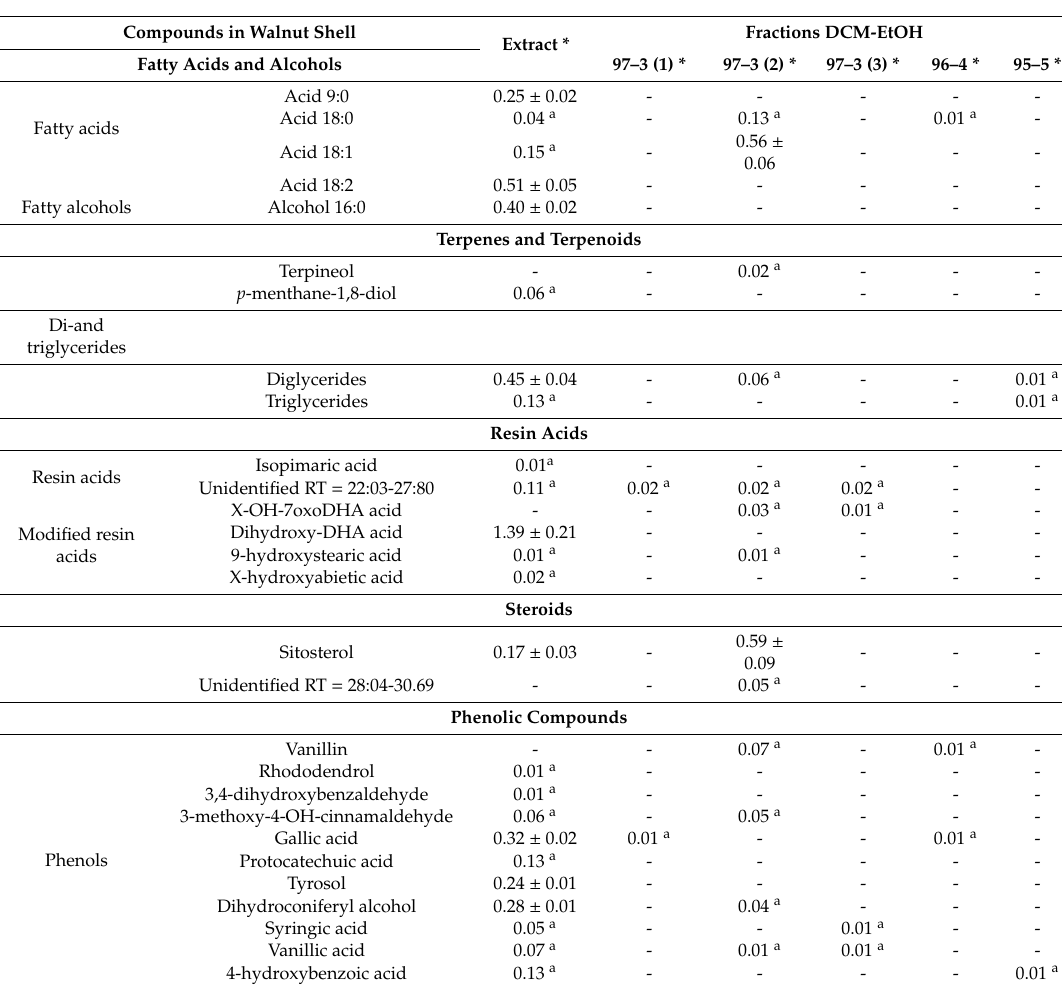
Table 4. Composition of crude WS extract and DCM-EtOH